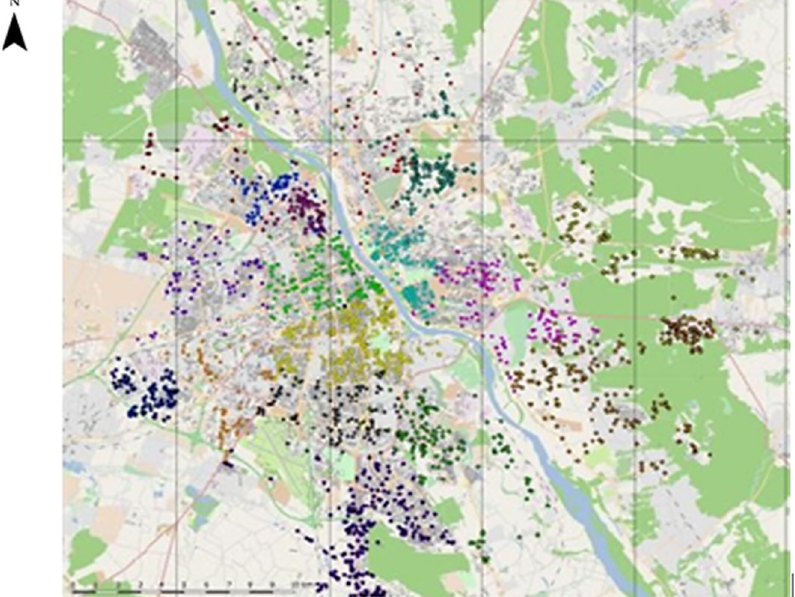
Figure 10. Fire brigade reports of interventions due to heavy rainfall in Warsaw in 2008–2013 (Note: different colours of the dots indicate different fire brigade units. The report shows that most of the operations took place in the southern part of Warsaw and covered the catchment area of the S ł u ż ewiecki Stream).